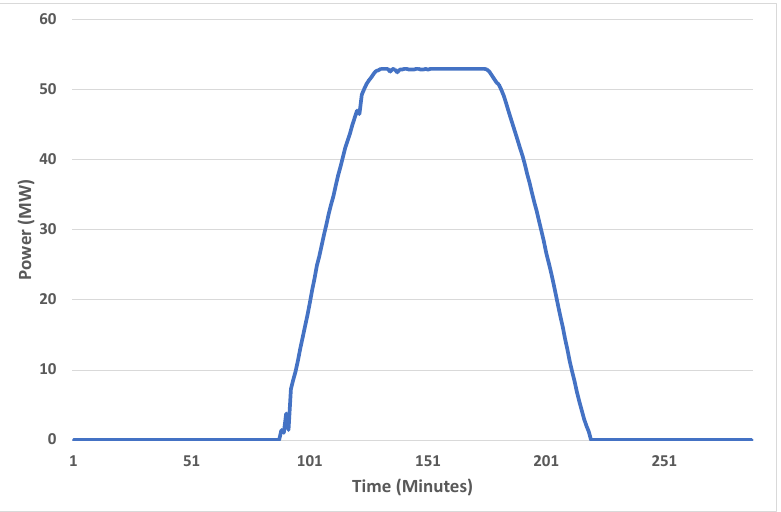
Figure 6. Clear sky